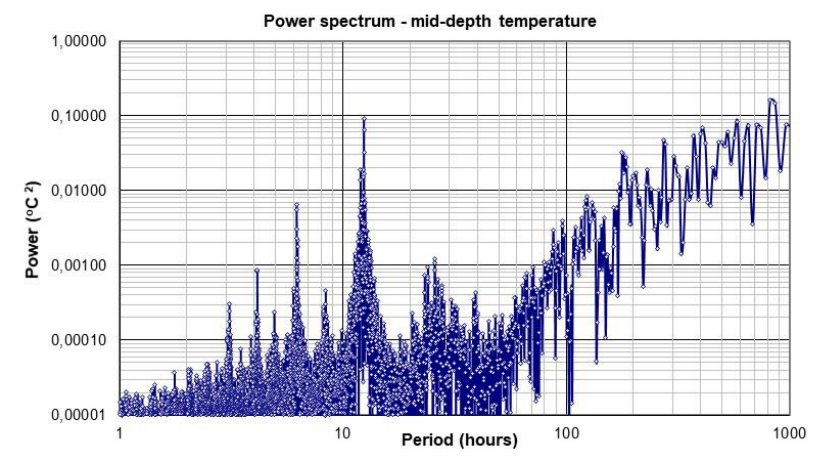
Figure 3. Power spectrum for mid-depth water temperature acquired inside the Guanabara bay; the local depth is 21 m.